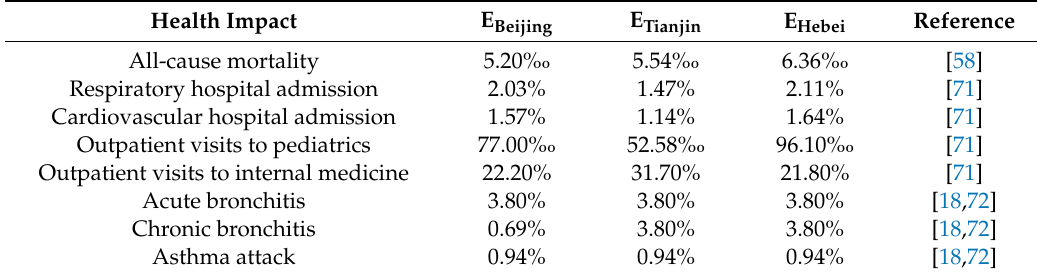
Table 2. Mortality and morbidity at the health endpoints used in the analysis (95% CI).